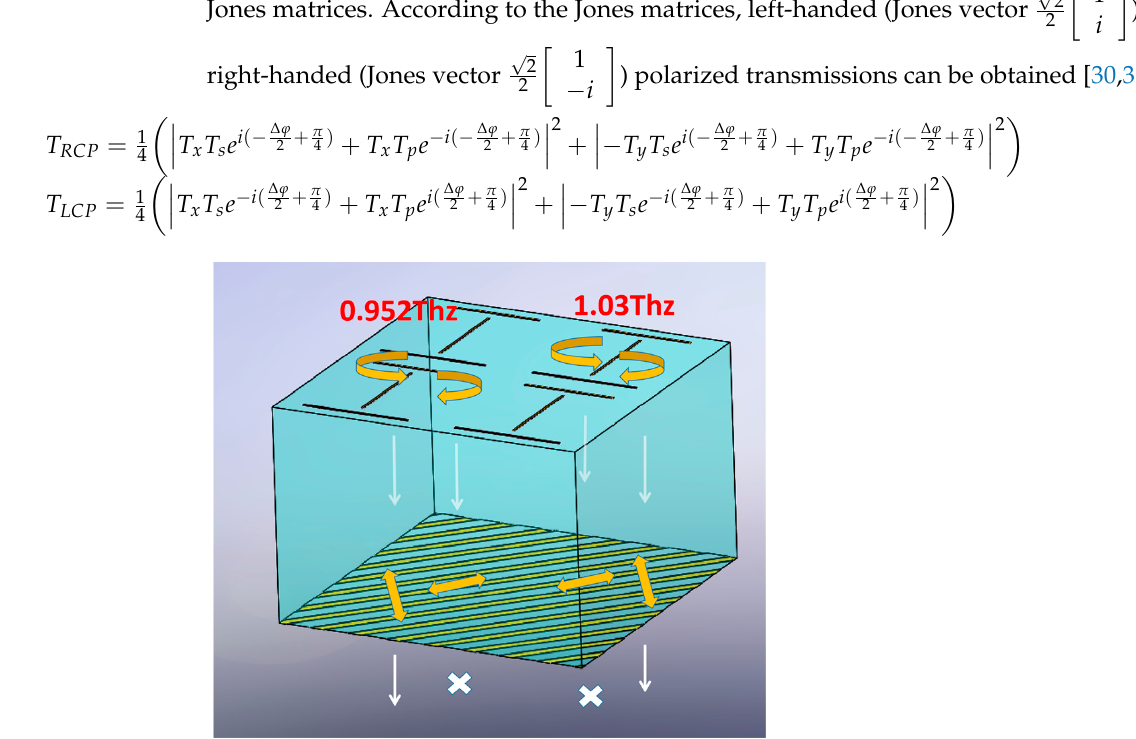
Figure 1. Schematic diagram and function of the structure of circular polarization detection. The upper layer is a quarter-wave plate consisting of mutually orthogonal Cu lines. The lower layer is a Cu wire grid and is oriented at 45° to the horizontal. In the terahertz band, metallic Cu can induce the excitations of surface plasma. Therefore, it can be used to design quarter-wave plates and filters. The two layers of metal are spaced apart by polyimide. The polyimide is transparent at this frequency and has a certain bending resistance. Therefore, it is an ideal material for use as a dielectric layer.